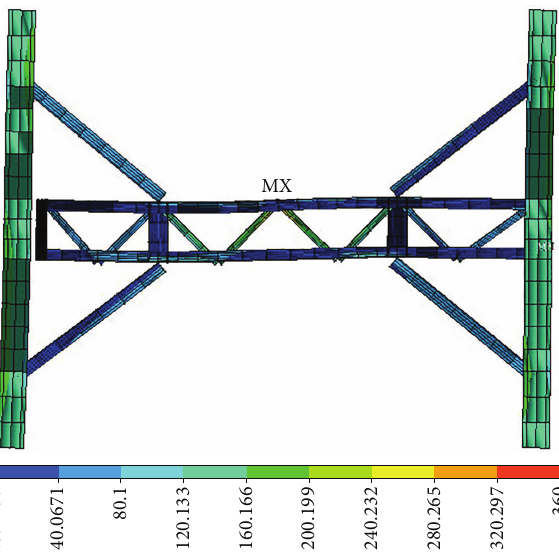
Figure 19: Stress when horizontal load is 59 kN.